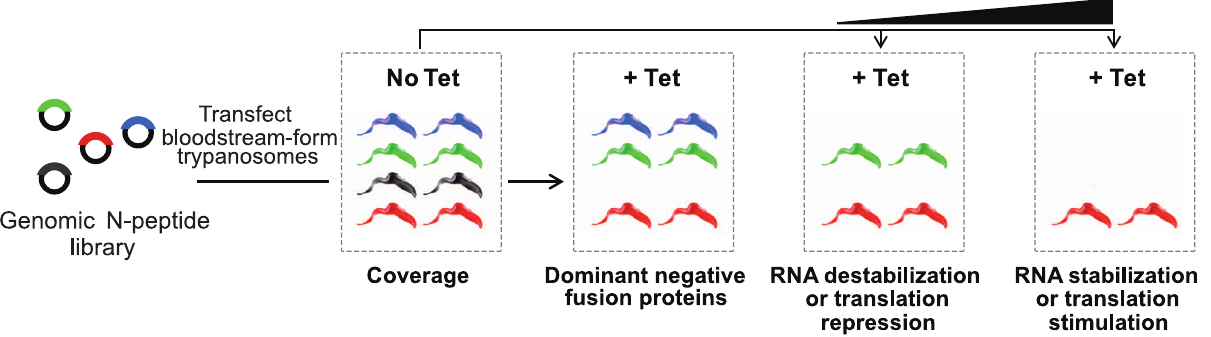
Figure 2. Schematic of the overexpression library and the growth conditions analyzed. After transfection, the library was grown under non-inducing (tet 2 ) and inducing conditions (tet + ) with increasing concentration of blasticidin and then, genomic DNA was isolated from survival populations. Adaptor-ligated sequencing libraries were prepared from specific PCR reactions and Illumina sequenced. Illumina sequencing reads containing a backbone vector junction sequence were then mapped to the T. brucei reference.